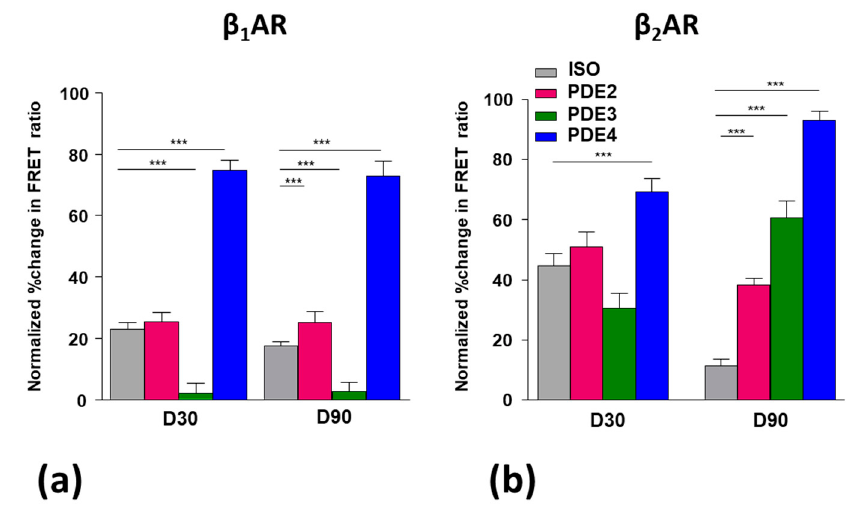
Figure 4. Influence of PDE2, 3, and 4 inhibition on the cAMP activity in D30 and D90 iPSC-CMs after stimulation with isoprenaline. ( a ) Normalised FRET ratio in iPSC-CMs at D30 following either β 1AR or β 2AR stimulation with isoprenaline (30 µM) in the presence of ICI (50 nM) (97/11) with subsequent PDE inhibition; in iPSC-CMs at D30 PDE2 (26/5), PDE3 (33/2), and PDE4 (38/6) and D90 with ISO (121/7) and the subsequent inhibition of PDE2 (48/3), PDE3 (51/2), and PDE4 (36/3); ( b ) normalised FRET ratio in iPSC-CMs at D30 following either β 1AR or β 2AR stimulation with isoprenaline (30 nM) in the presence of CGP (100 nM) (38/4), with the subsequent inhibition of PDE2 (10/3), PDE3 (22/7), and PDE4 (33/3) in iPSC-CMs at D30 and D90 with ISO (19/3) and the subsequent inhibition of PDE2 (55/7), PDE3 (8/3), and PDE4 (33/3). PDE inhibitors were used following isoprenaline stimulation (EHNA (10 µM), cilostamide (10 µM), rolipram (10 µM); the percentage change in the FRET ratio was normalised to the maximal cAMP produced upon AC activation with NKH477. Data are presented as mean ± SEM. Significance was determined by one-way ANOVA with Bonferroni’s post-hoc test. *** p < 0.001. n/N = cells/batches. T = significant from D30.